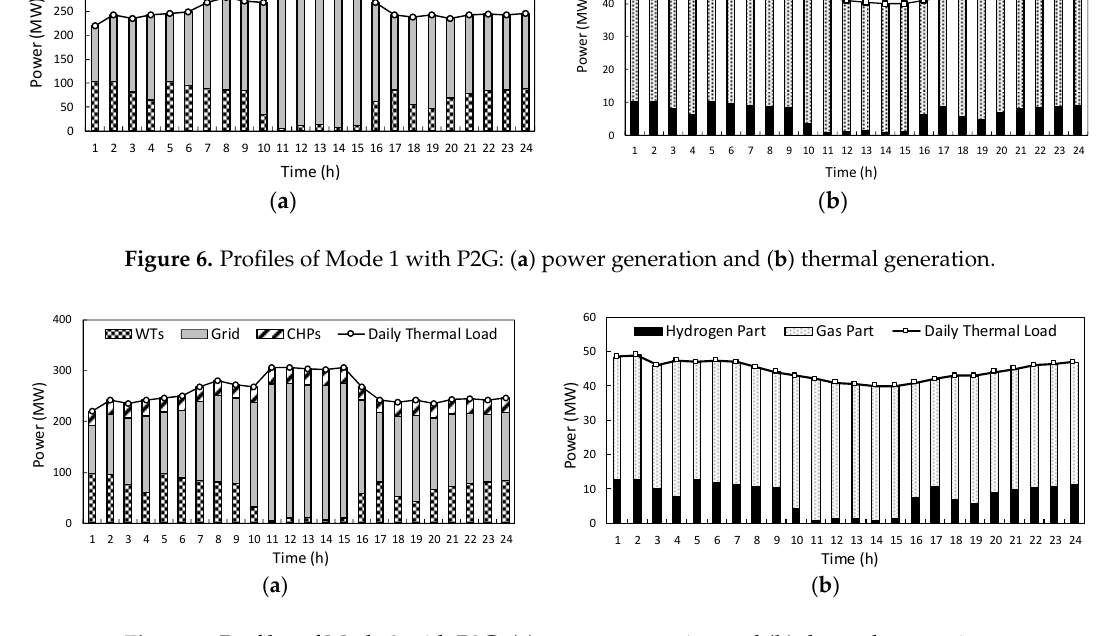
Figure 7. Profiles of Mode 2 with P2G: ( a ) power generation and ( b ) thermal generation.